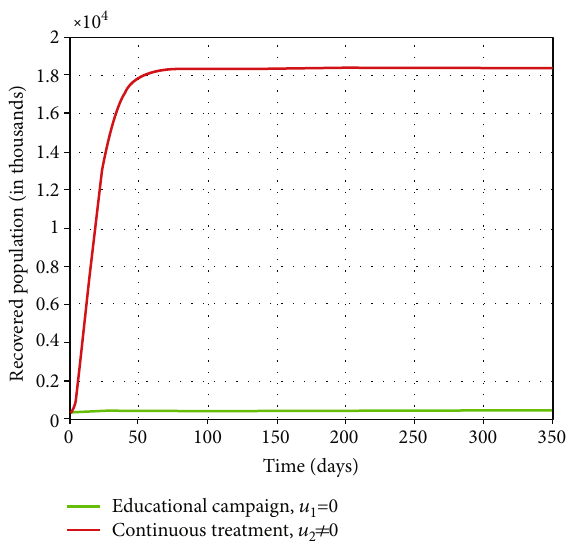
Figure 17: Recovered individuals with and without intervention strategy u 2 .